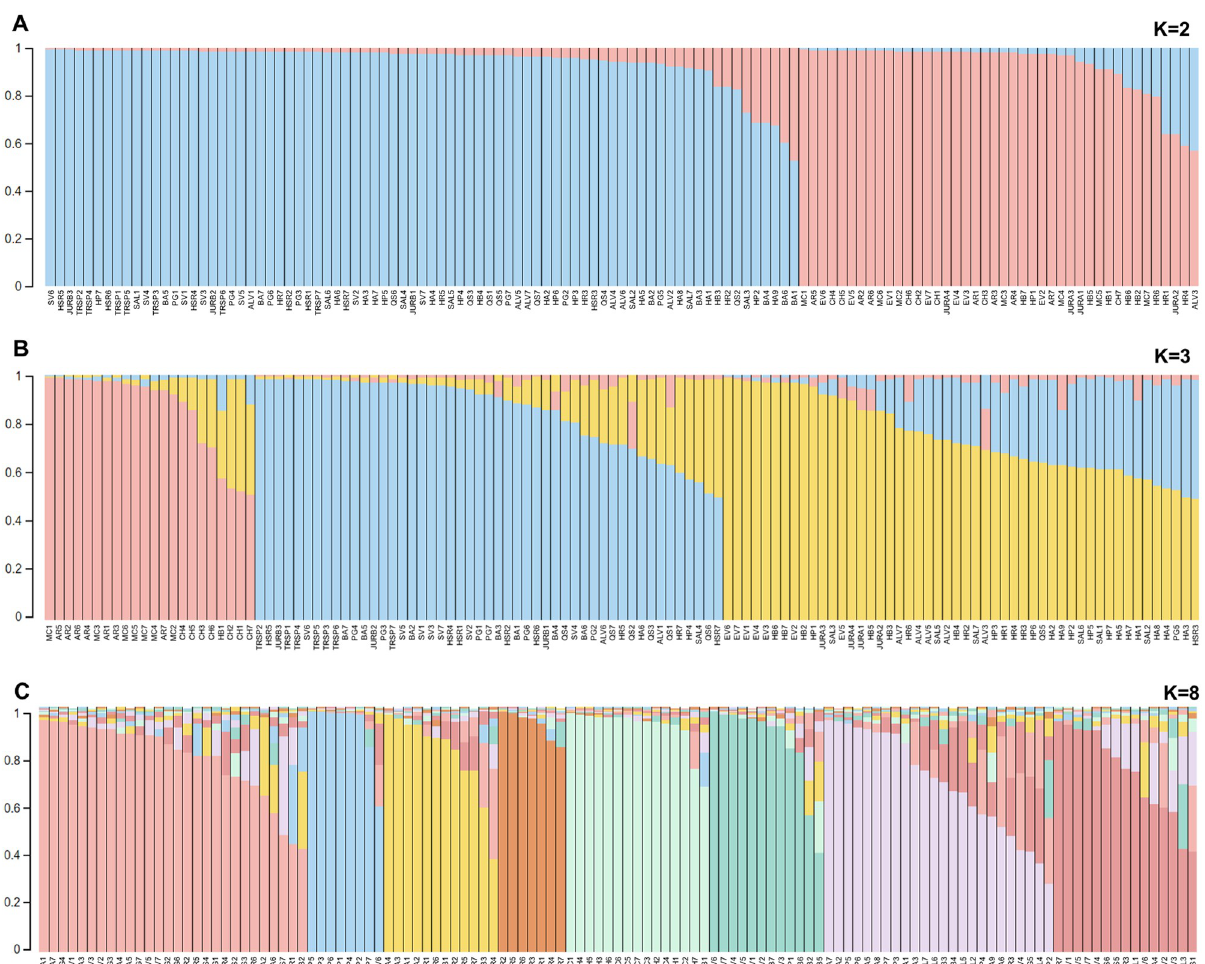
Fig 3. Structure analysis based on 121 genotypes of Cynara cardunculus . Genetic clusters inferred from the population structure analysis at K = 2 (A), 3 (B) and 8 (C), are represented by individual colors. Each sample (represented by a vertical bar) is partitioned into colored segments representing the estimated membership coefficients ( q values). Genotypes names (geographic location followed by genotype number) are indicated on the x axis. Bar colors indicate the groups identified through the STRUCTURE program.